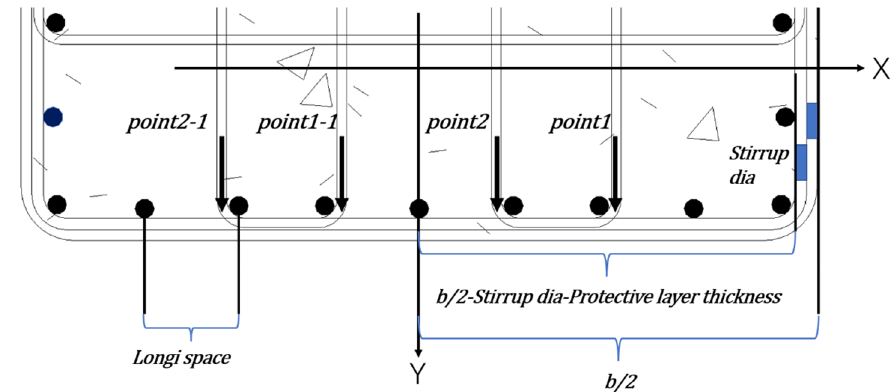
Figure 8. T schematic diagram of the coordinates of the corner points of the additional stirrups.